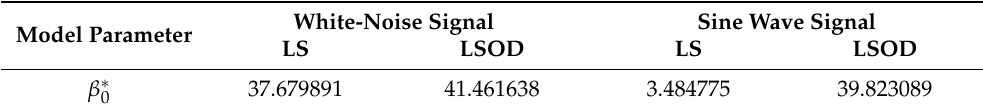
Table 3. Parameter identification of the servo system model (54).